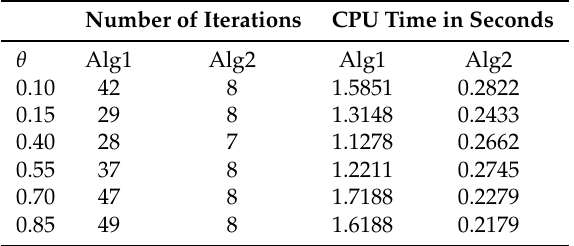
Table 3. Example 2: Algorithm 1’s numerical comparison with Algorithm 1 in [19]. Number of Iterations CPU Time in Seconds θ